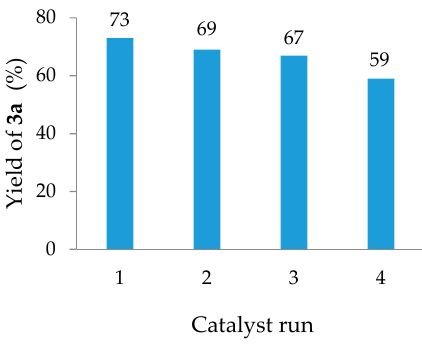
Figure 1. Reusability of [Bmim][Al 2 Cl 7 ] (1.2 mmol) in the sulfinylation of 1,3-dimethoxybenzene (1 mmol)